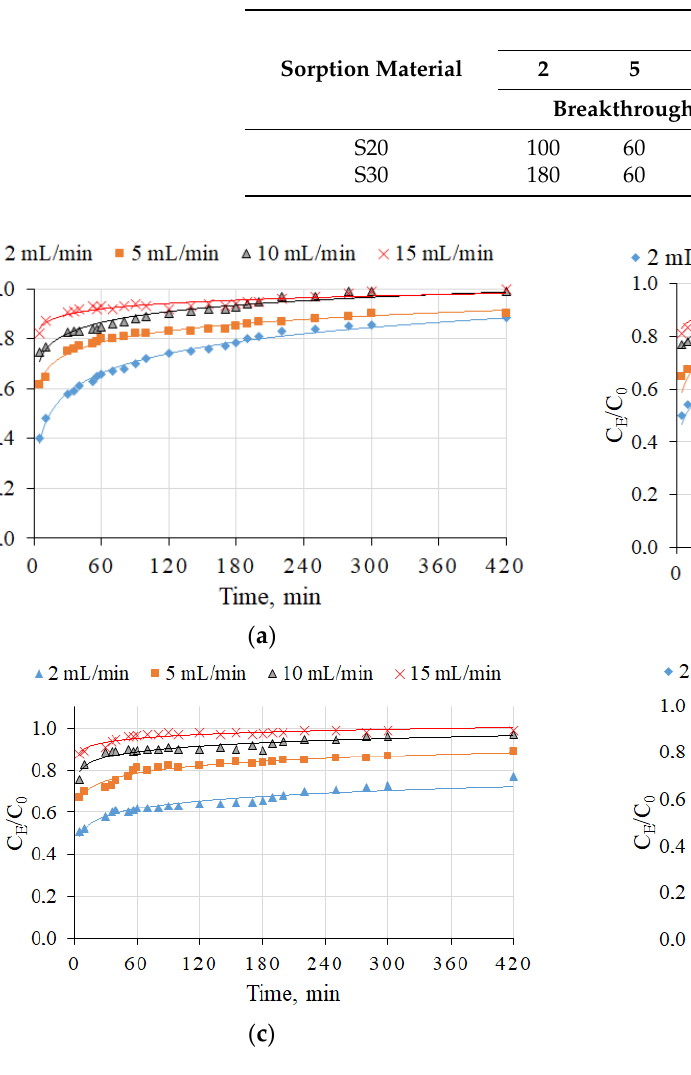
Figure 3. The influence of the flow rate on the breakthrough curves for NH 4+ ion sorption by straetlingite-based sorbents in a synthetic aqueous solution: ( a ) S10 (according to the Table 1); ( b ) S15; ( c ) S20; ( d ) S30. The initial NH 4+ ion concentration in the synthetic aqueous solution was 10 mg/L and the filtration rates were 2, 5, 10, and 15